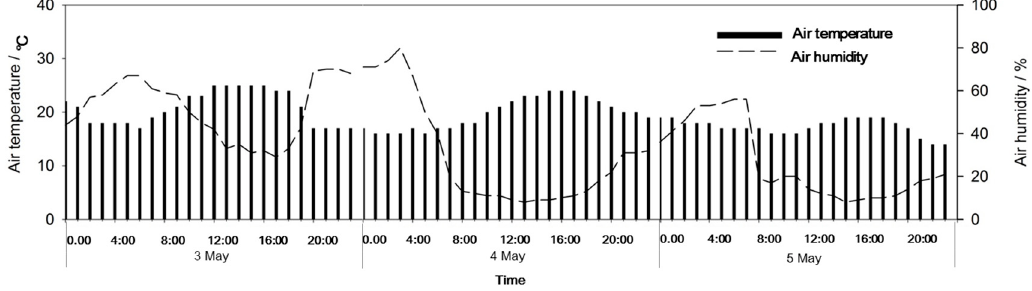
Figure 2. Air temperature and humidity during dust storm on 3–5 May, 2017 in Beijing.